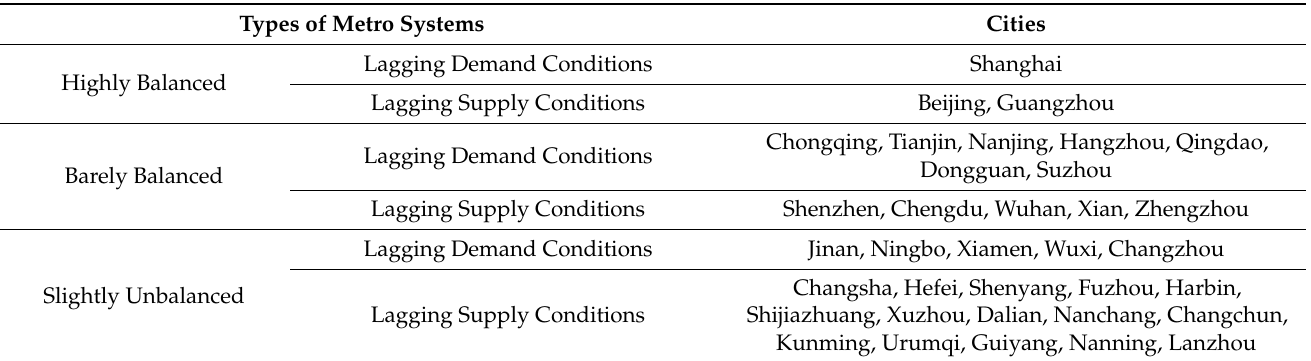
Table 8. Categories of metro systems.